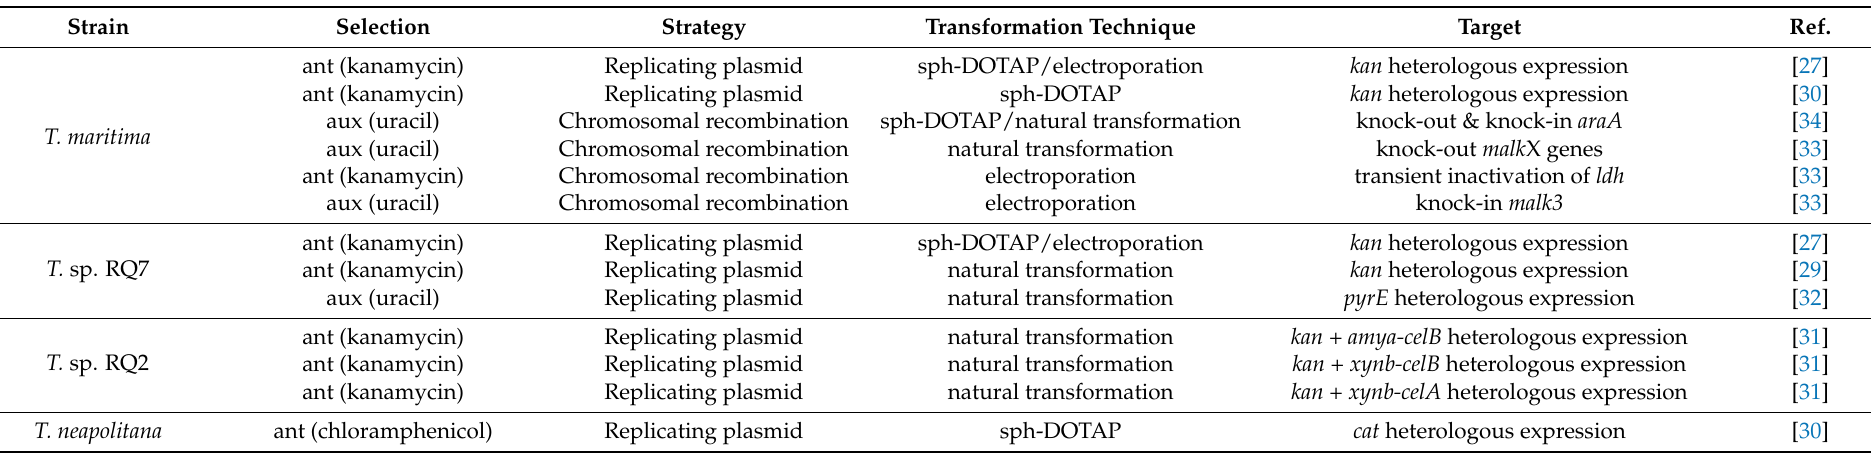
Table 1. Genetic manipulation reported for Thermotoga genus. Antibiotic (ant), auxotrophy (aux), and spheroplast (sph). All replicating plasmid used in the above-mentioned studies are based on the sequence of endogenous cryptic plasmid